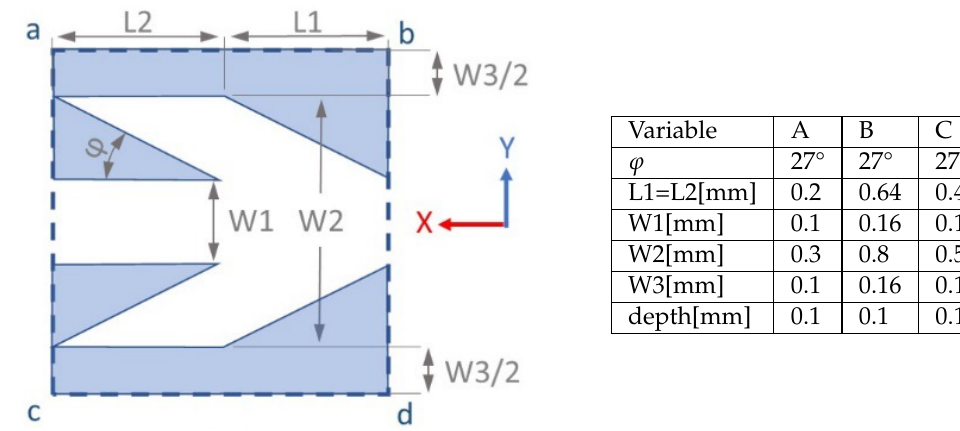
Figure 4. A single cell of the pattern from which is deduced the capillaries. The blue colored part is the fused melted metal with a height of 0.1 mm. The bottom of the capillary colored white. Both parts create an elementary cell which is included in the rectangle ‘abcd’. Adding copies of this rectangle adjacent to its parallel to y sides defines one channel and its walls. Then, adding adjacent copies of the ensemble forms the capillaries for structure A, B or C.